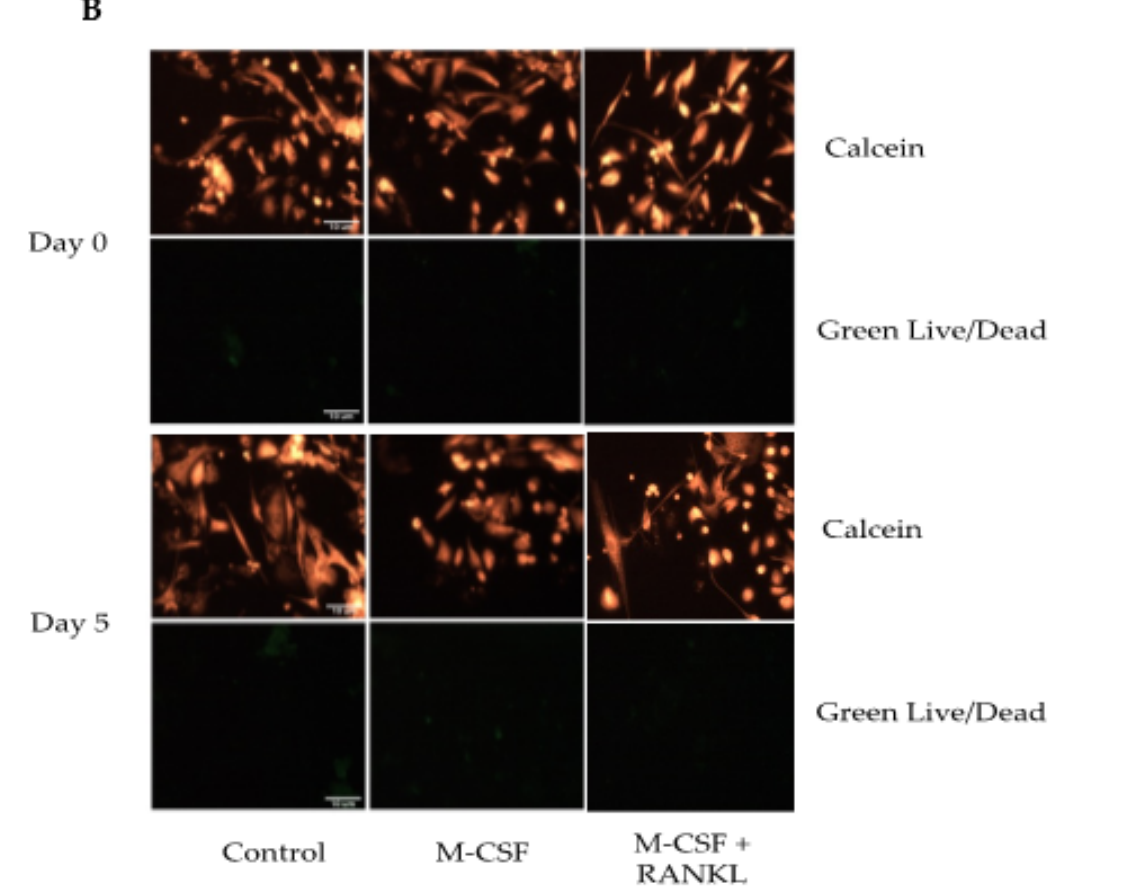
Figure 6. Calcein-AM-red-orange and Green Live/Dead staining for proliferation and viability. ( A ) Graphical representation of Calcein-AM fluorescence in different conditions. ( B ) Visual representations of Calcein-AM and Live/Dead stains. Cells were counted for 5 days, and immunofluorescence was captured using an epifluorescent microscope. Calcein-AM is indicative of the total number of viable cells, whereas green indicates an unviable cell. Scale bars are set to 10 µ m. All experiments were conducted in triplicate and images were processed using ImageJ.